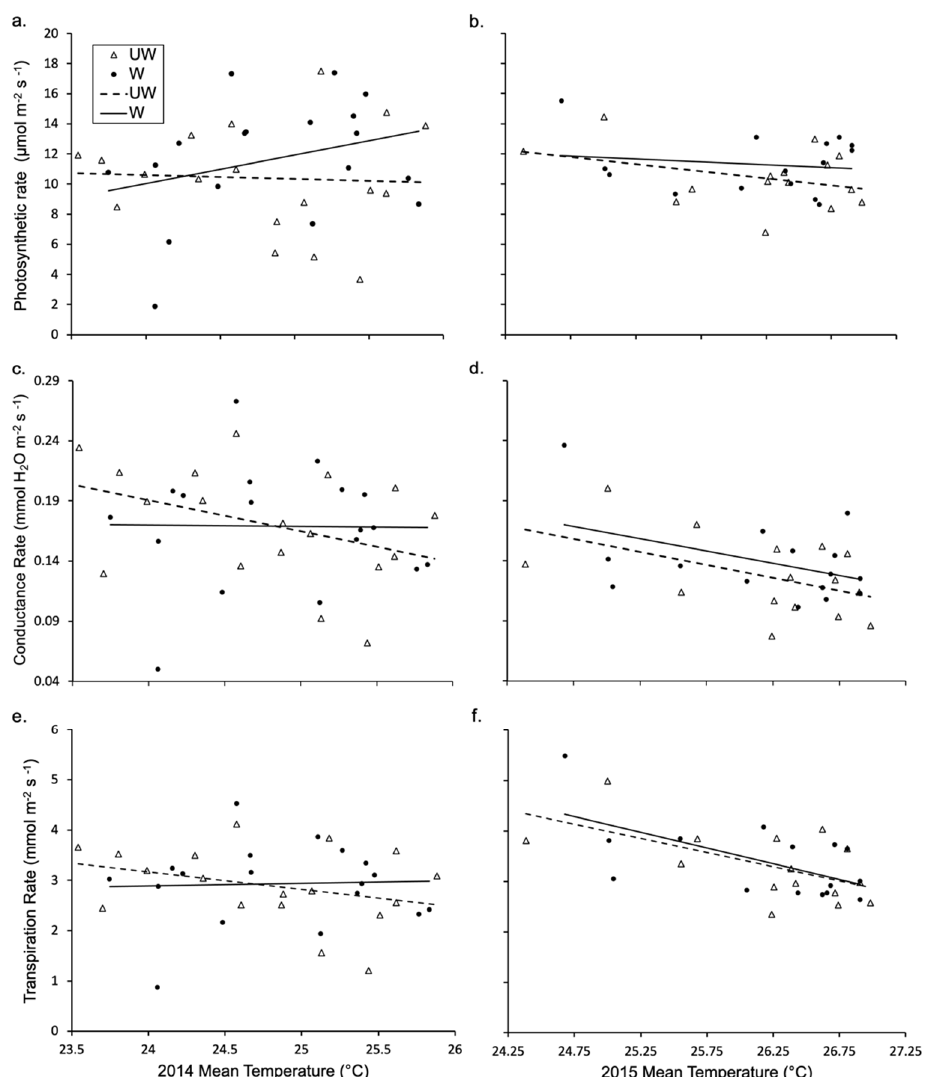
Figure 2. Regression plots of tree canopy temperature predicting leaf-level services for 2014 ( left column) and 2015 ( right column). ( a , b ) Photosynthesis rate, ( c , d ) stomatal conductance rate, and ( e , f ) transpiration rate. W = watered and UW = unwatered trees.